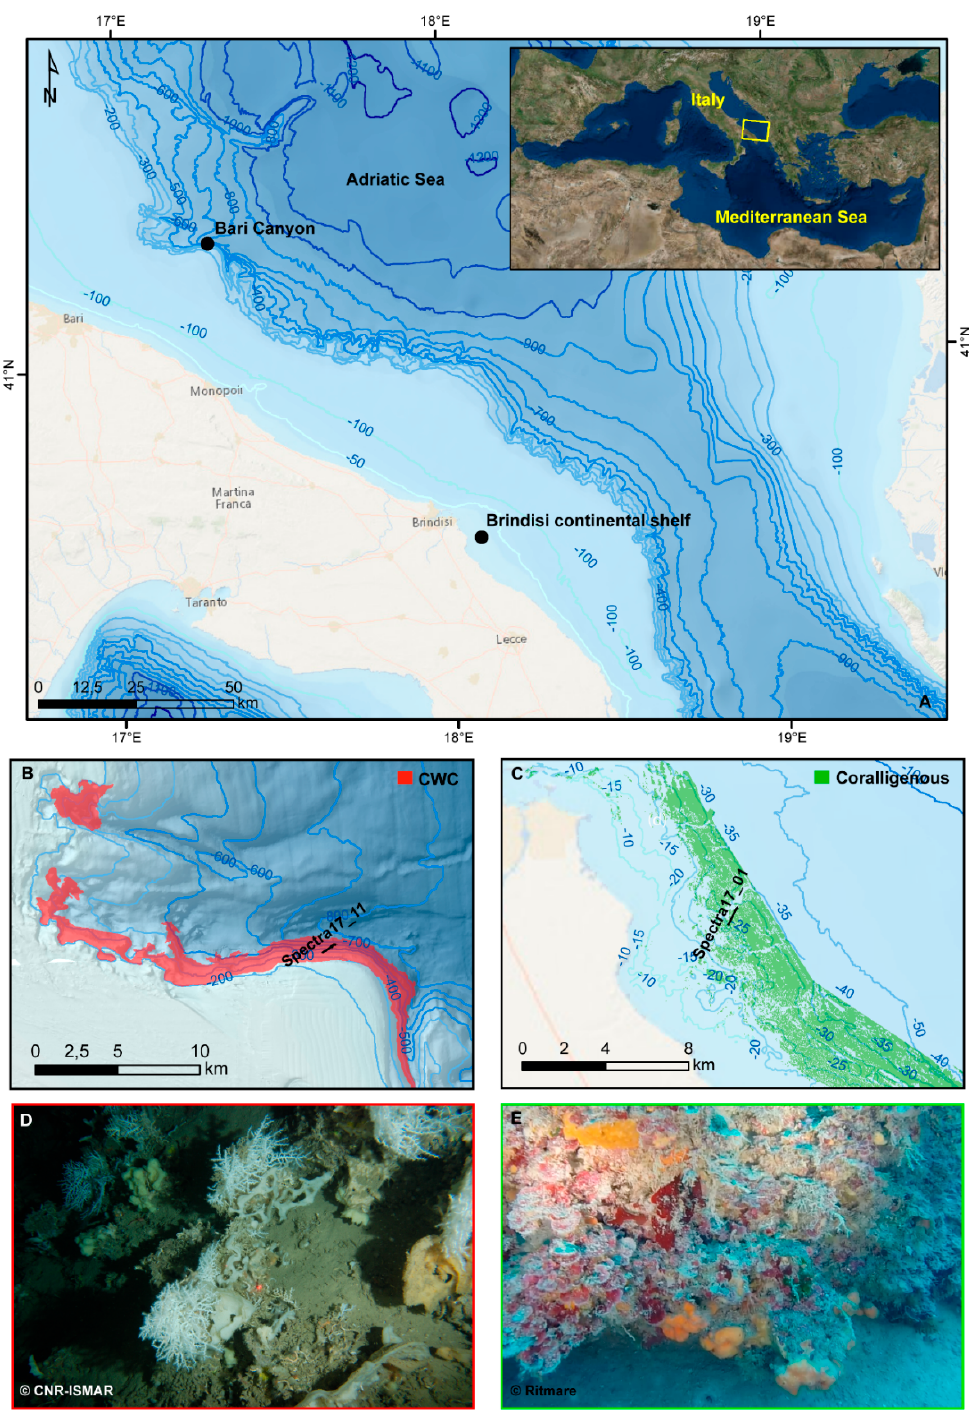
Figure 1. ( A ) Location of the two sites, inset shows the position in the Mediterranean Sea; ( B ) the extension of the Bari Canyon CWC province (from [56]) and ( C ) the extension of the coralligenous in the Brindisi area (black lines indicate the ROV surveys). Habitat maps produced by the BIOMAP project and further updated within the CoCoNet project. ( D ) Example of CWC habitat complexity showing colonies of M. oculata and large fan-shaped sponges (from [38]); ( E ) example of coralligenous characterized by CCA and Peyssonelliales, serpulids and orange encrusting sponges overprinting the calcified red algae.